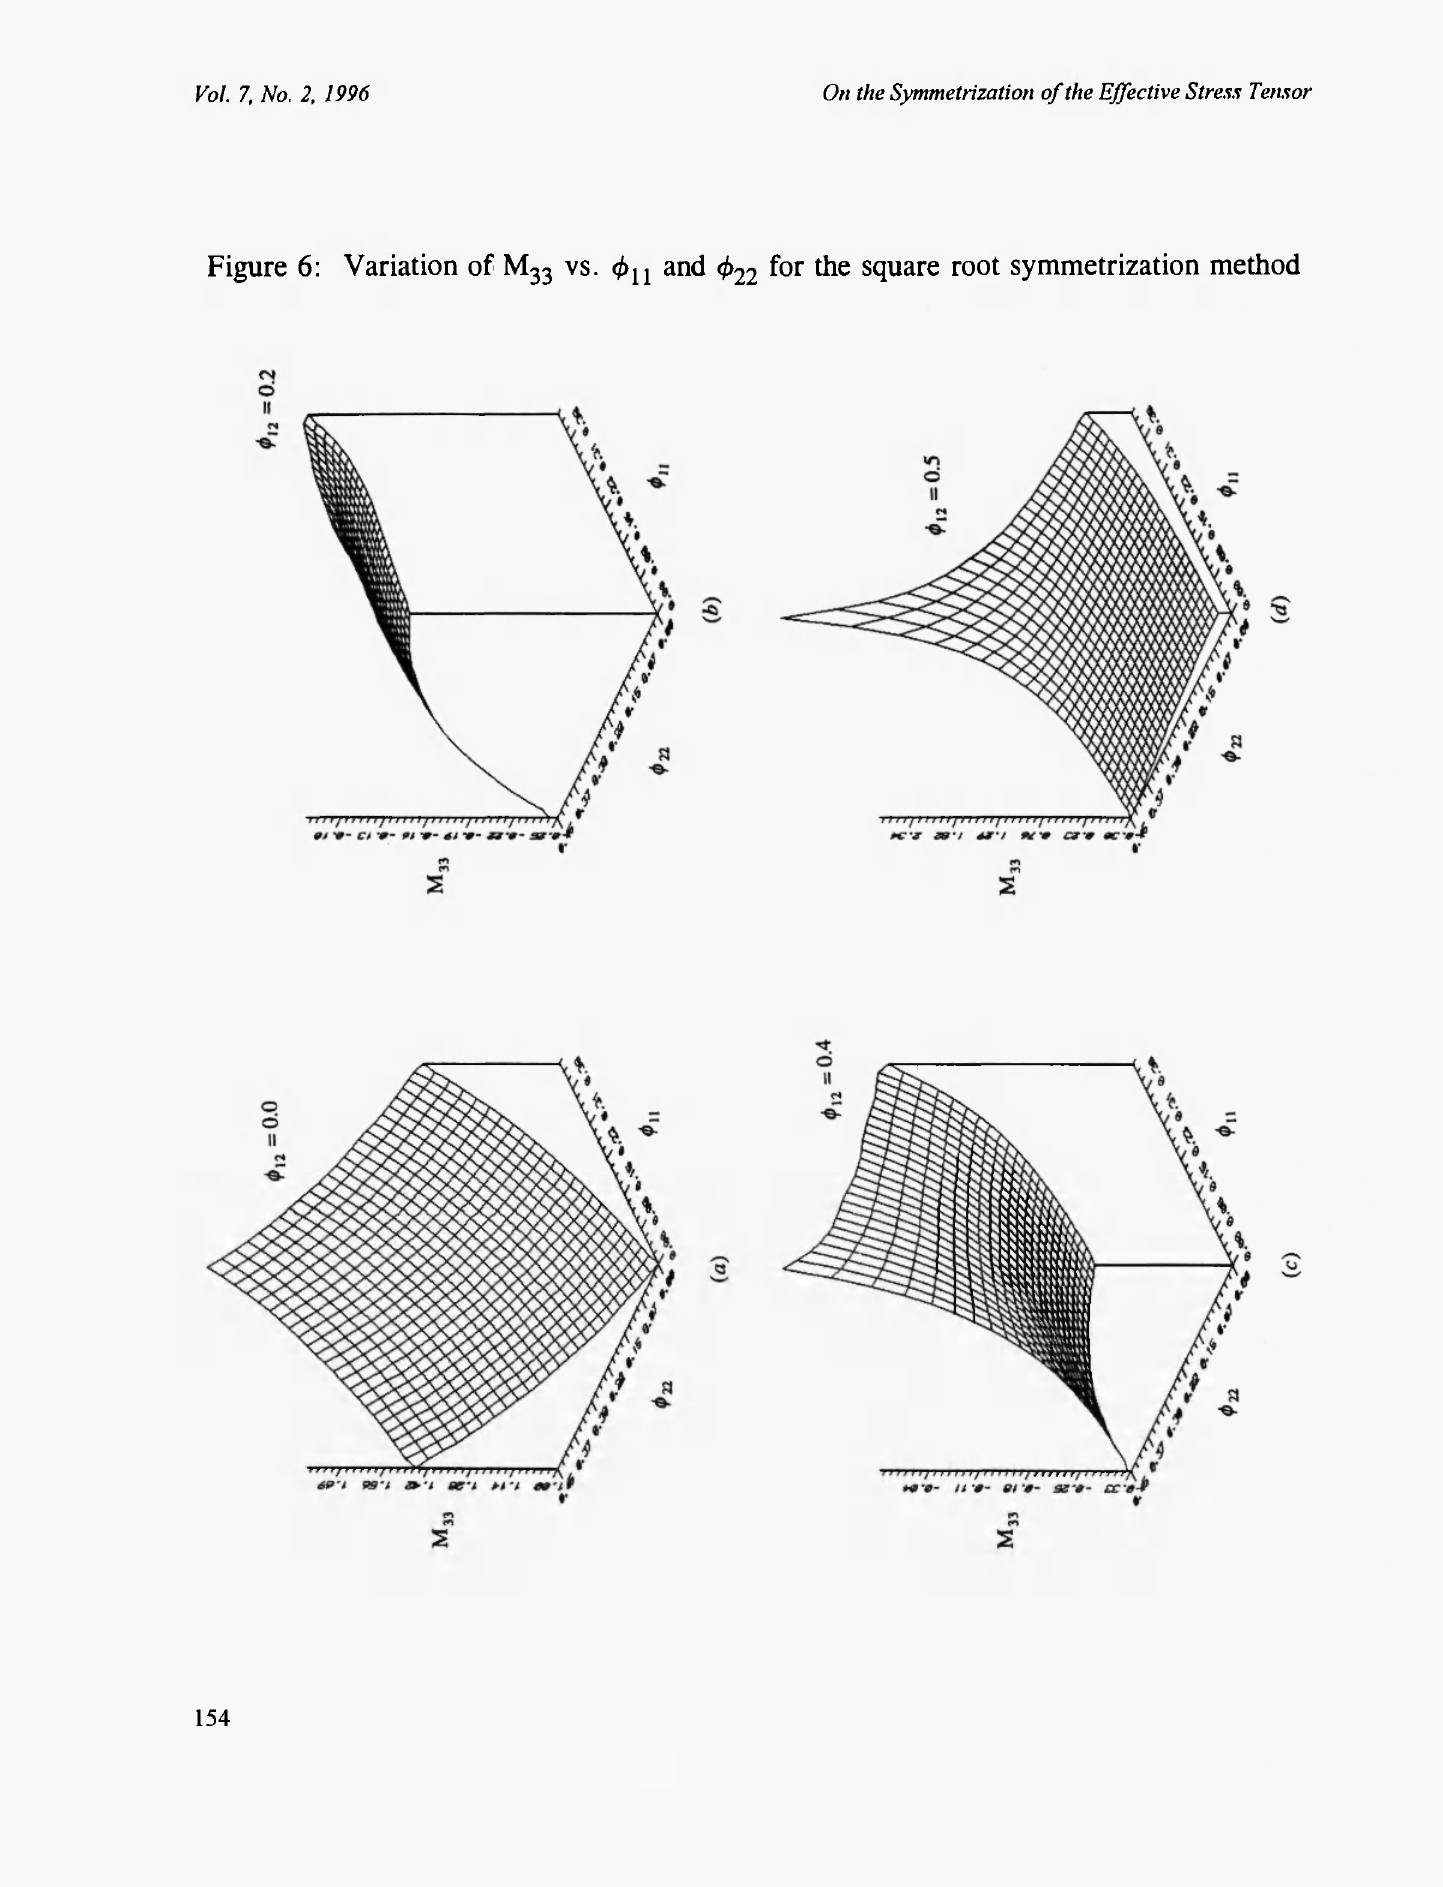
Figure 6: Variation of M